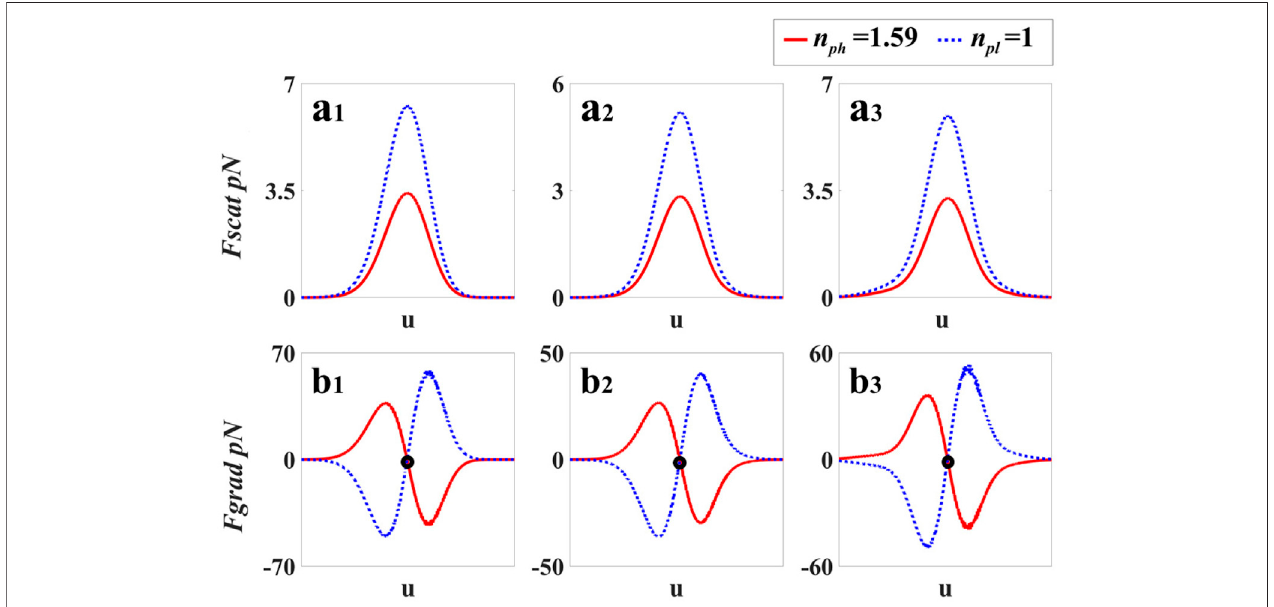
FIGURE3 | Radiation forces ofthe twokinds ofparticlesinlinearOVbeams. The blue dashed linesand the red solid lines represent theparticleswith lowand high refractive indices, respectively. (A 1 – A 3 ) Scattering force with different numbers of kinks. (B 1 – B 3 ) Gradient force with different numbers of kinks.